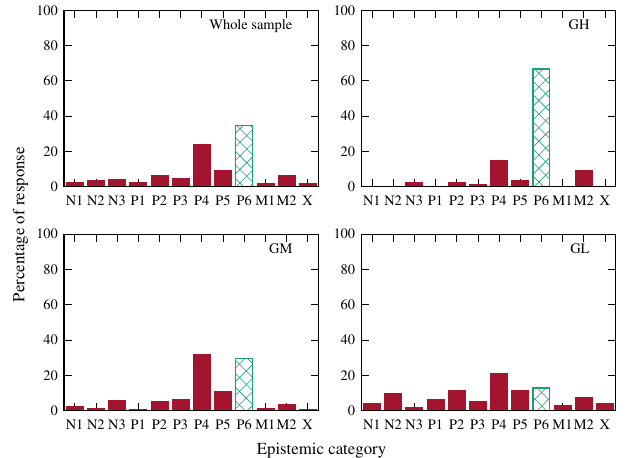
FIG. 11. Aggregate distribution of responses to the only propo- sition (S35) corresponding to epistemic category P6. Format of the figure is the same as in Fig. 4.